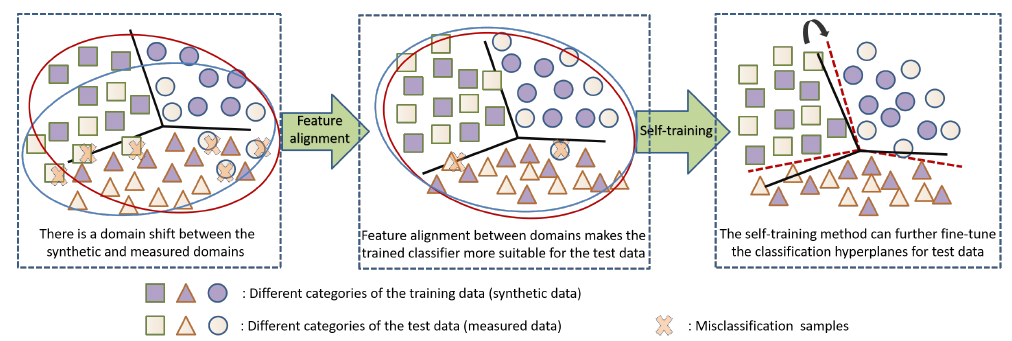
Figure 1. Illustration of the gradual domain adaptation process, which is a feature alignment classification network with